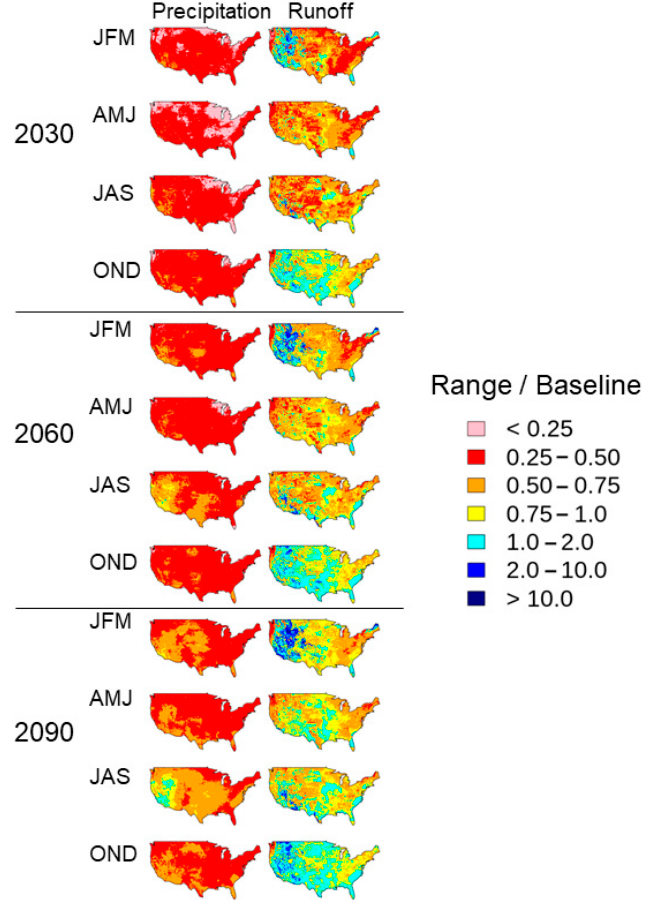
Figure 7. Range (95th percentile − 5th percentile) of departures divided by the baselines in seasonal average monthly precipitation and runoff projected for 2030, 2060, and 2090 from 214 climate simulations. JFM, January–March; AMJ, April–June; JAS, July–September; OND, October–December.